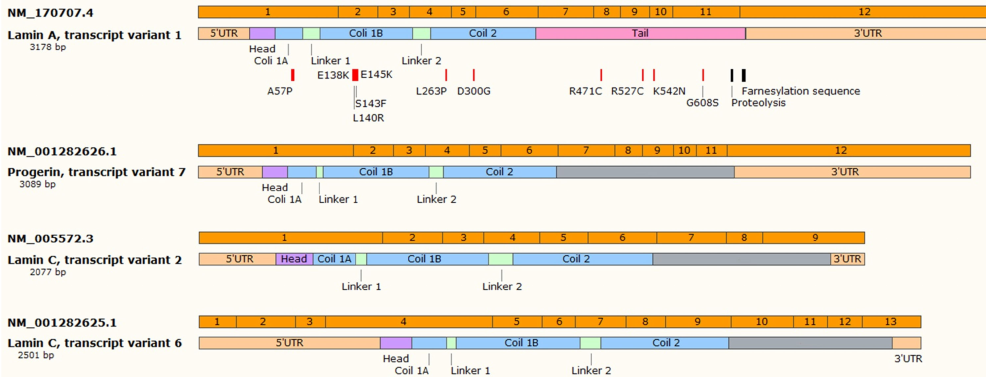
Figure 1. The selected transcripts of LMNA gene—transcript variant 1 (coding for lamin A protein) and transcript variants 2 and 6 (coding for lamin C), and transcript variant 7 arisen from mutated LMNA gene (coding for progerin). Farnesylated sequence and proteolytic site are indicated for lamin A transcript, as well as possible mutations in protein-coding sequence. Indicated miR-9-binding sites are present both in mRNA variant 1 and 7. siRNA binding site in present only in mRNA variant 7. Figure created based on NCBI